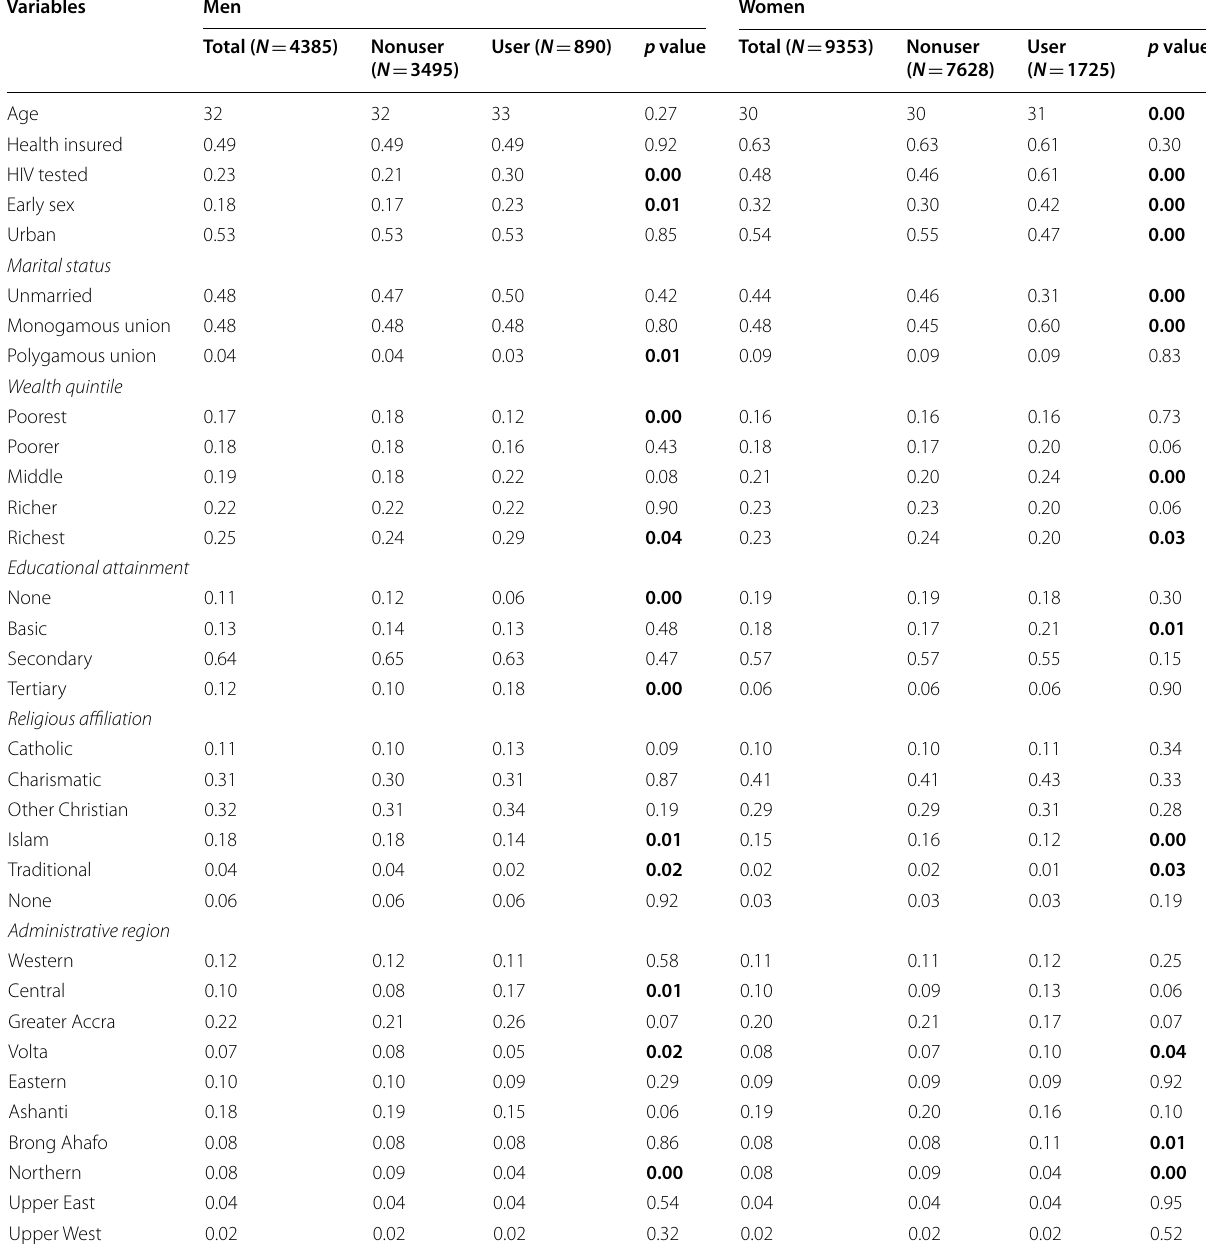
Sampling weights applied to make estimates nationally representative; means and p values of adjusted Wald test for association reported ( H o : no relationship ), bold indicate statistically significant values at 95% confidence interval ( p <